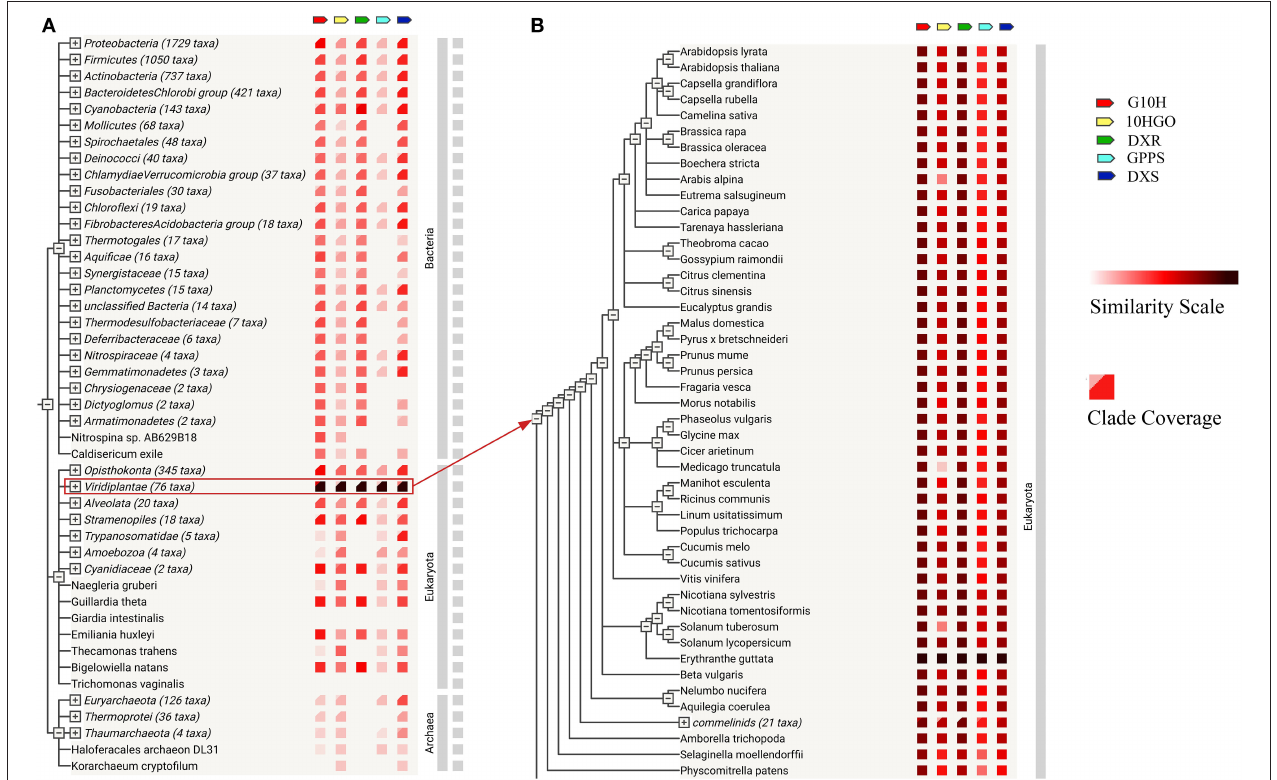
FIGURE 3 | Co-occurrence on iridoid glycoside synthetase genes of R. glutinosa . (A) Gene co-occurrence of DXS , DXR , GPPS , G10H, and 10HGO in organism. (B) The co-occurrence of DXS , DXR , GPPS , G10H, and 10HGO in plants. Similarity scale: The color indicates the similarity of gene and its homology in the given STRING. Clade coverage: Two distinct colors, respectively, denote the lowest and highest similarity observed within the